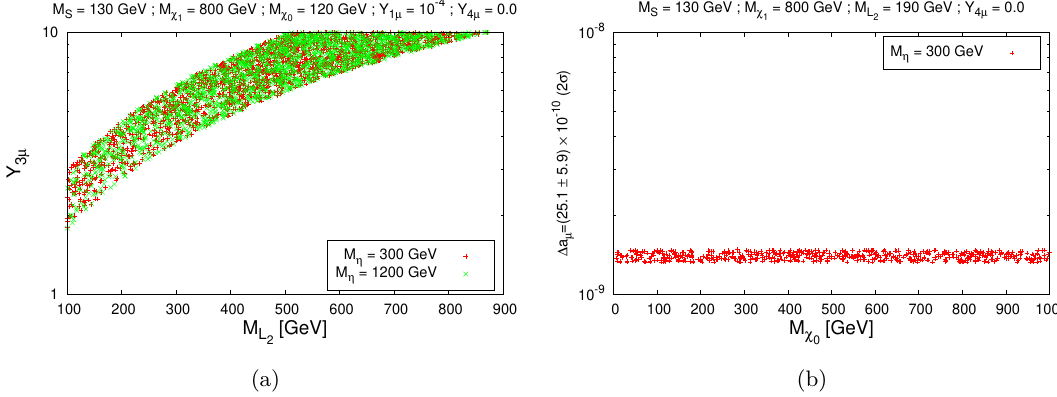
Figure 4 . Allowed parameter space satisfying ∆ a µ within 2 σ bound. Here sin θ = 0 . 01 is assumed. Here, red and green dots represent the scenarios corresponding to M 1200 GeV